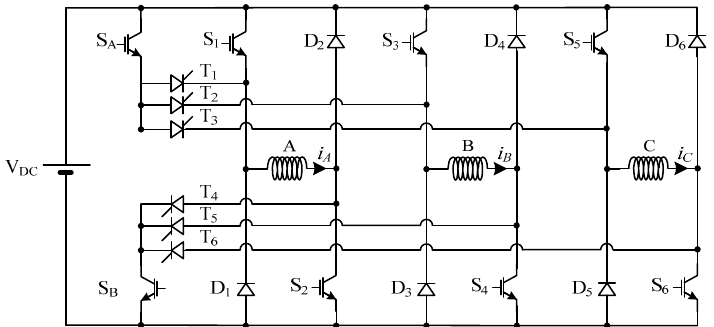
Figure 22. Fault-tolerant topology proposed by [87], combining the classic AHB with two additional controlled power semiconductors and six